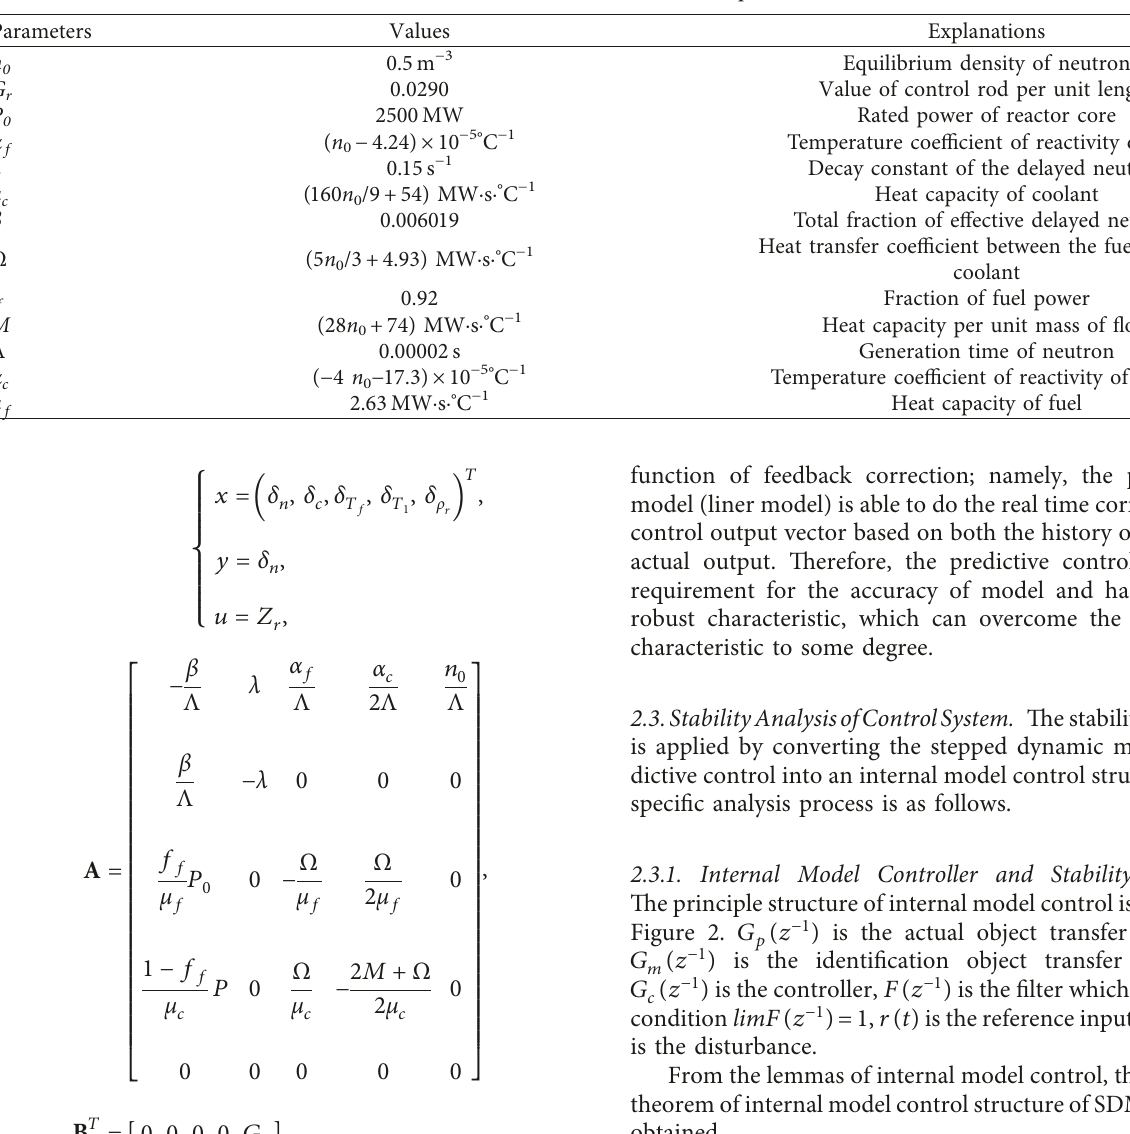
Table 1: Data for simulation of PWR plant